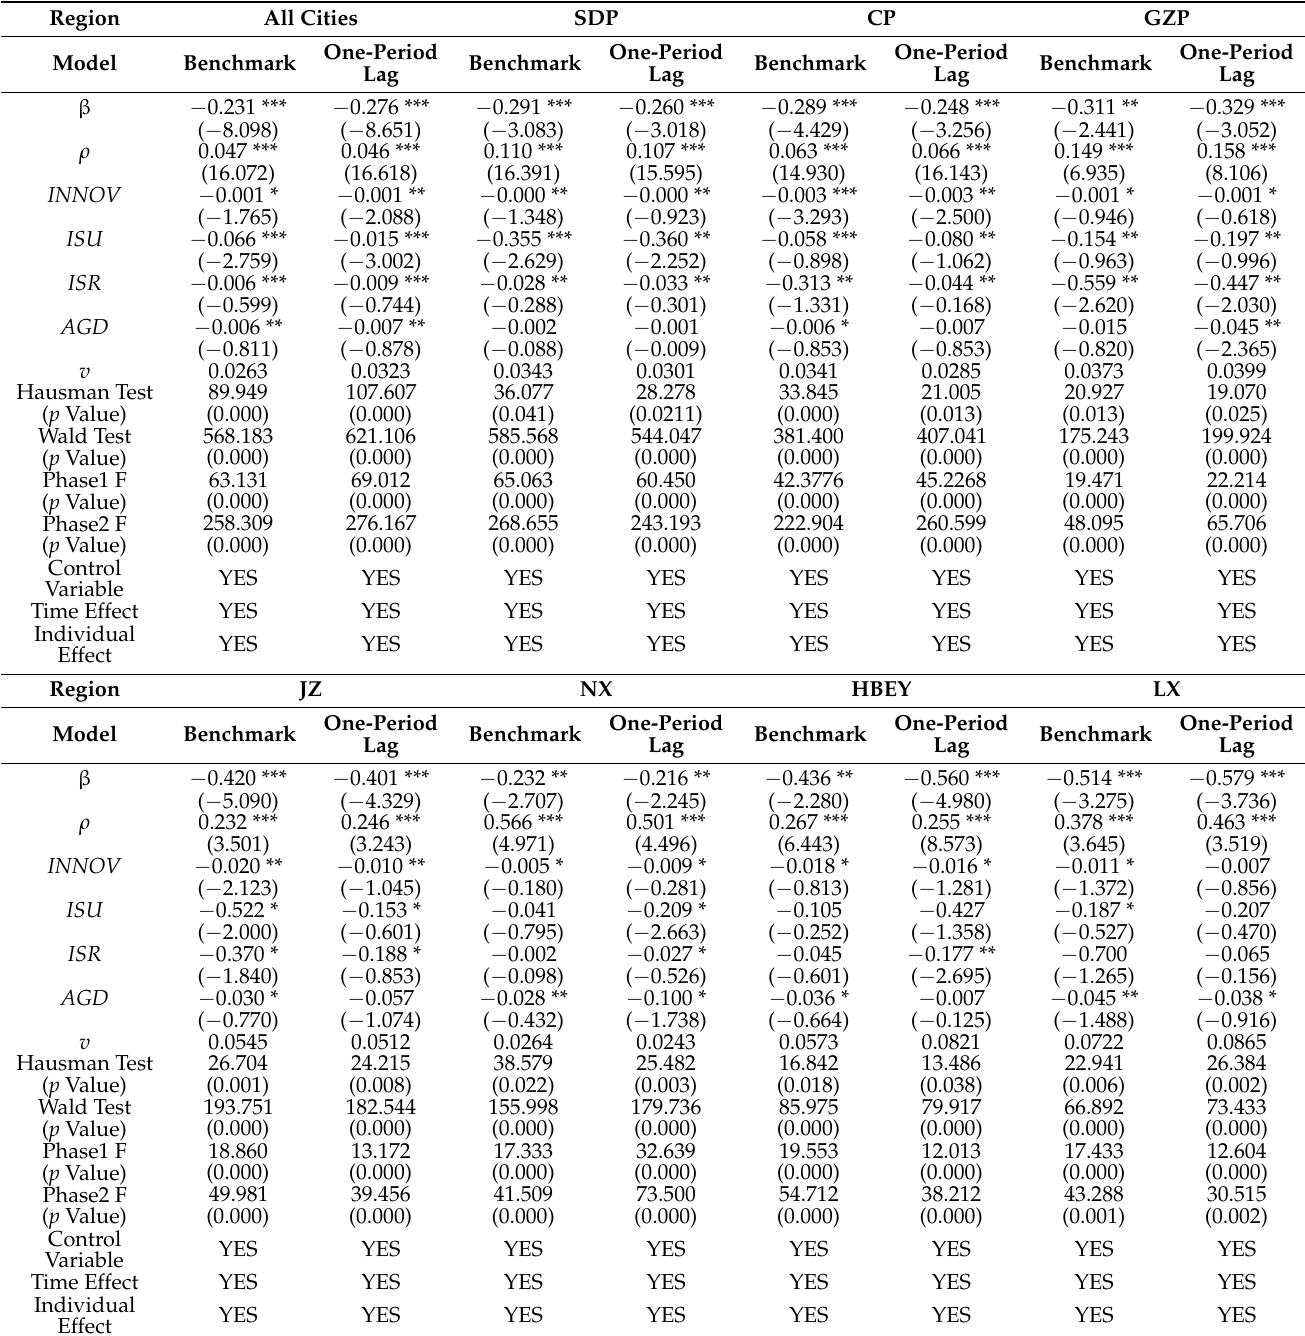
Table 9. Robustness test based on